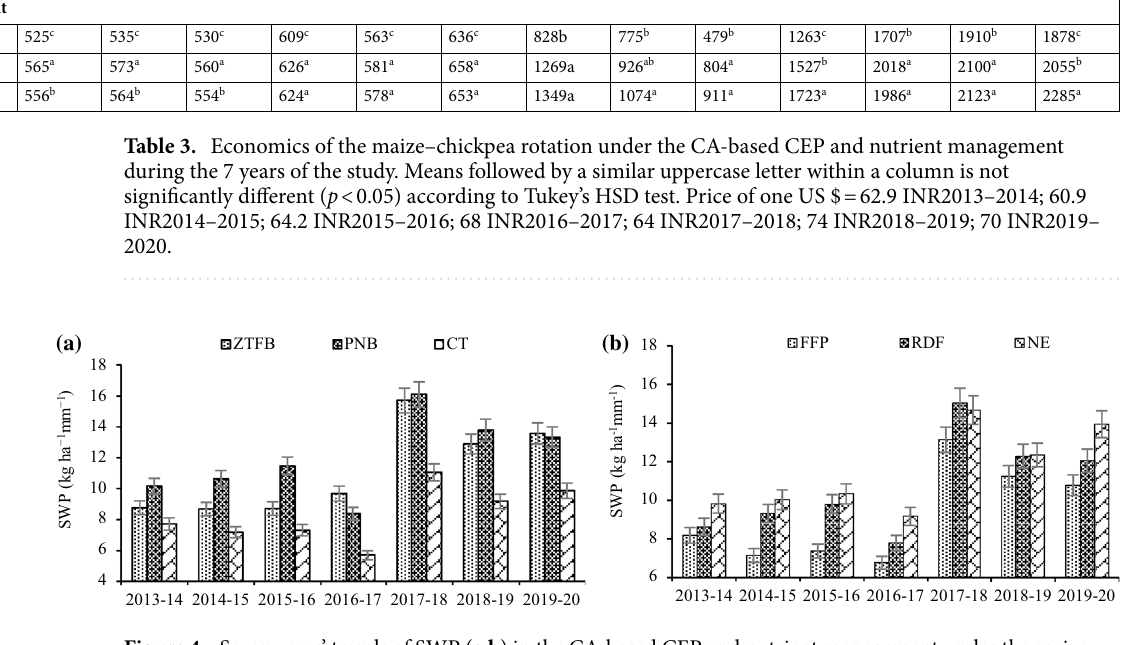
vest of the seventh season maize, soil samples were collected from the 0.0–0.50 m soil depth (Fig. 5a). Among the